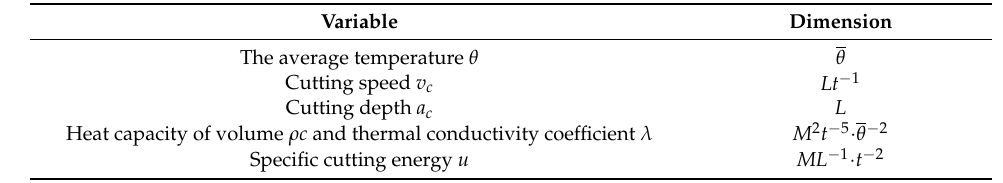
Table 3. Dimensional analysis of the factors affecting the average temperature θ